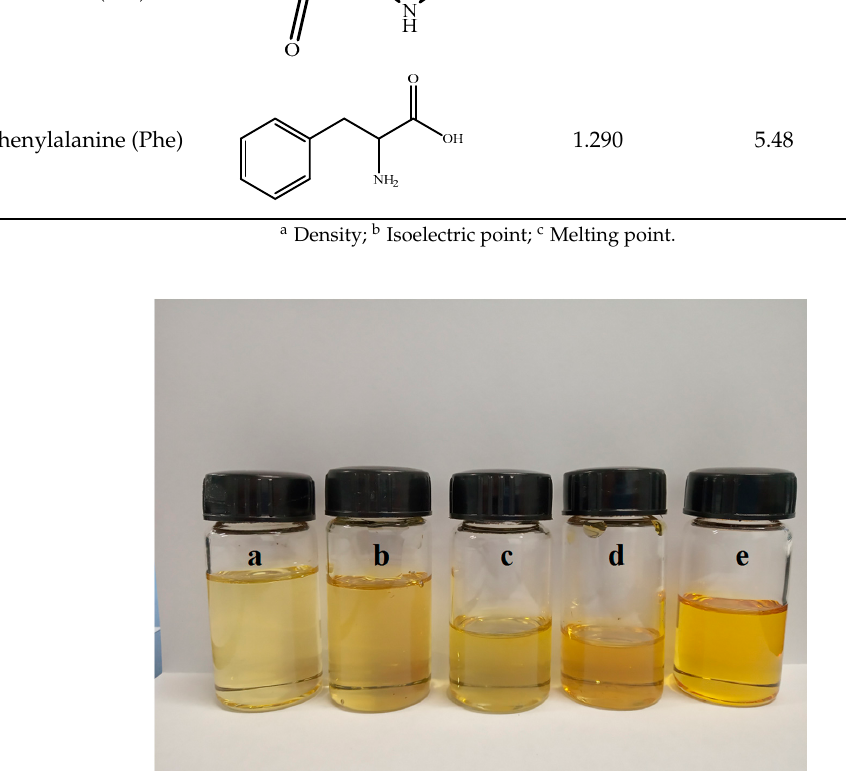
Figure 1. Photographs of samples under ambient conditions: ( a ) choline glycine (ChGly), ( b ) choline histidine (ChHis), ( c ) choline serine (ChSer), ( d ) choline proline (ChPro), and ( e ) choline phenylalanine (ChPhe).